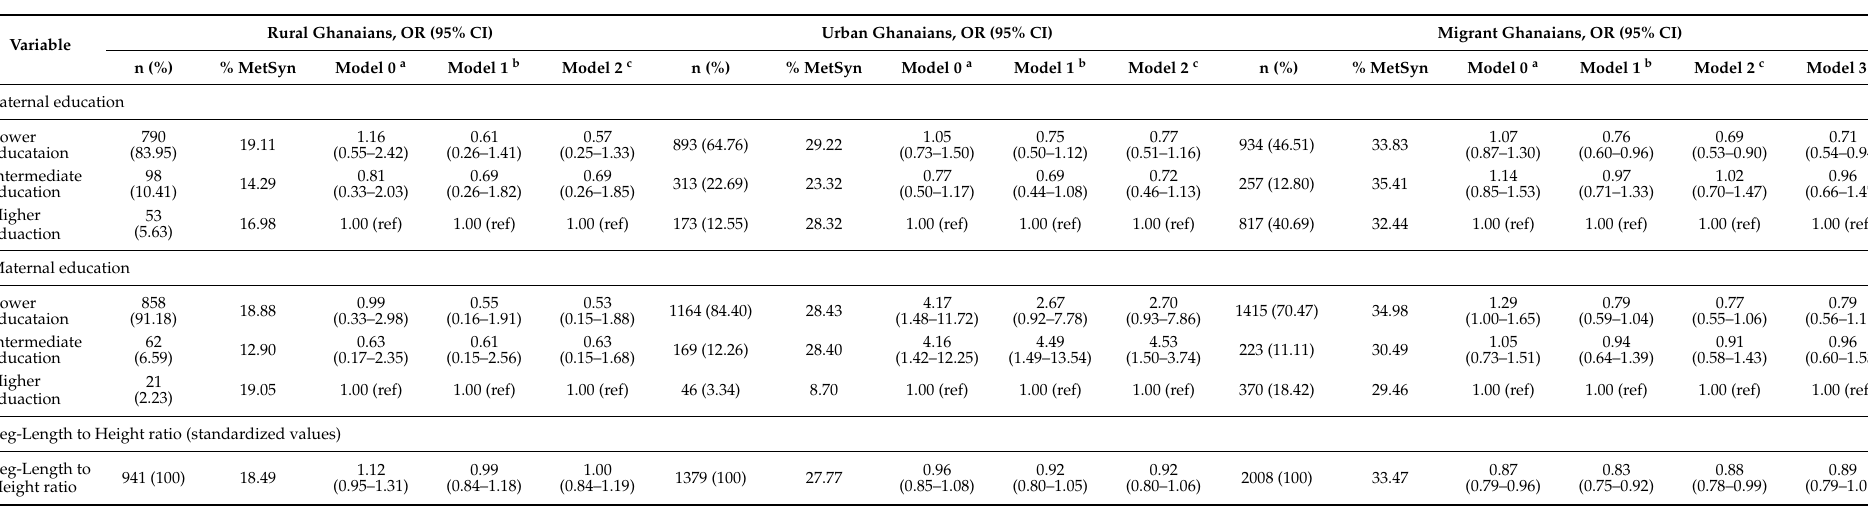
Table 3. Associations between early life factors and metabolic syndrome in the Research on Obesity and Diabetes among African Migrants (RODAM) study population (N = 4328) in the migrated Ghanaians, rural Ghanaians and urban Ghanaians. Rural Ghanaians, OR (95% CI) Urban Ghanaians, OR (95% CI) Migrant Ghanaians, OR (95% Variable